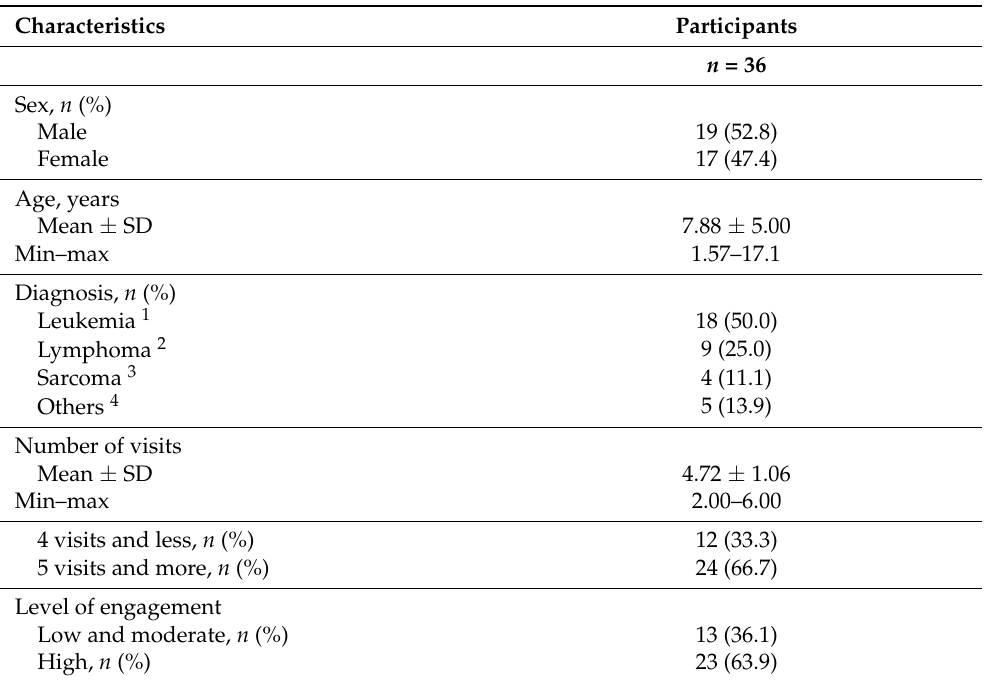
Table 1. Characteristics of the